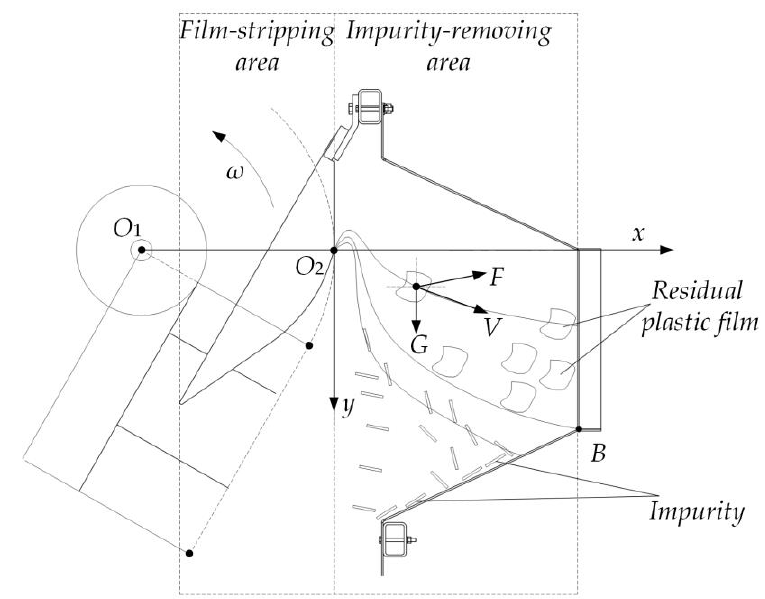
Figure 5. Analysis of force and movement of RPF in the airflow field.